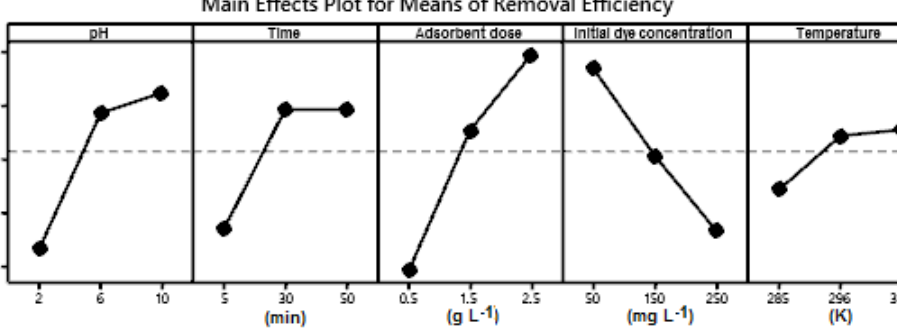
Figure 3. The response curves for the individual effects of dye adsorption parameters on S/N ratio and dye removal effi- ciency.